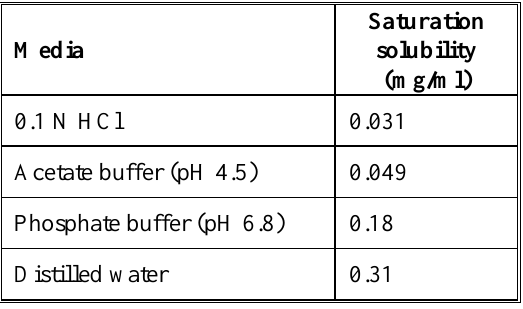
Table 2. Saturation solubility of